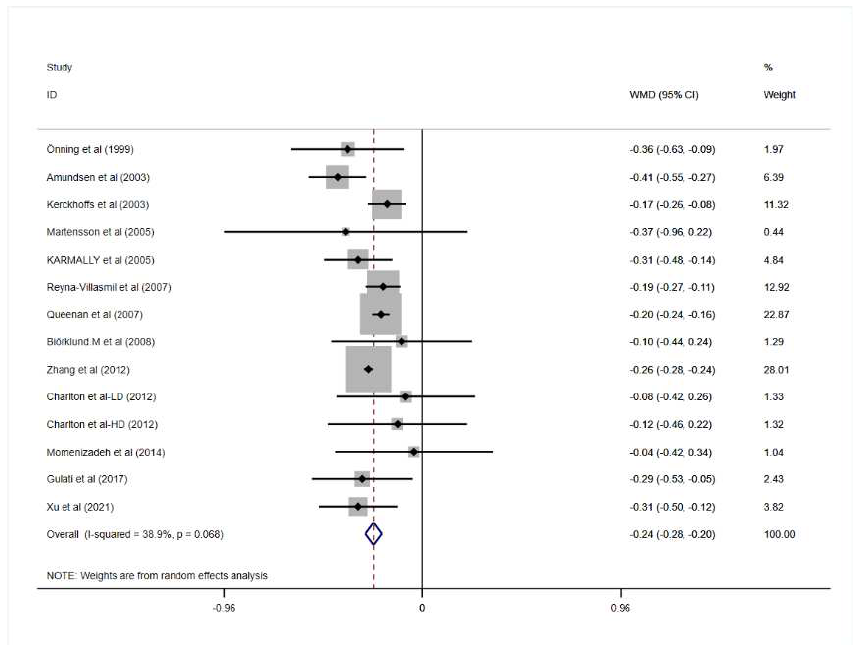
Figure 2. Effect of oat β-glucan on total cholesterol (mmol/L) in patients with hyperlipidemia. Open diamonds: synthesis of summary results of all studies; Filled diamonds: point estimates for effect of each study; Dashed lines: summary effect estimate which is labeled as a dashed line perpendicular to the X axis; Grey squares: the weight of each study, the value of weigh is proportional to the diamond size. WMD: weighted mean difference [18–30].